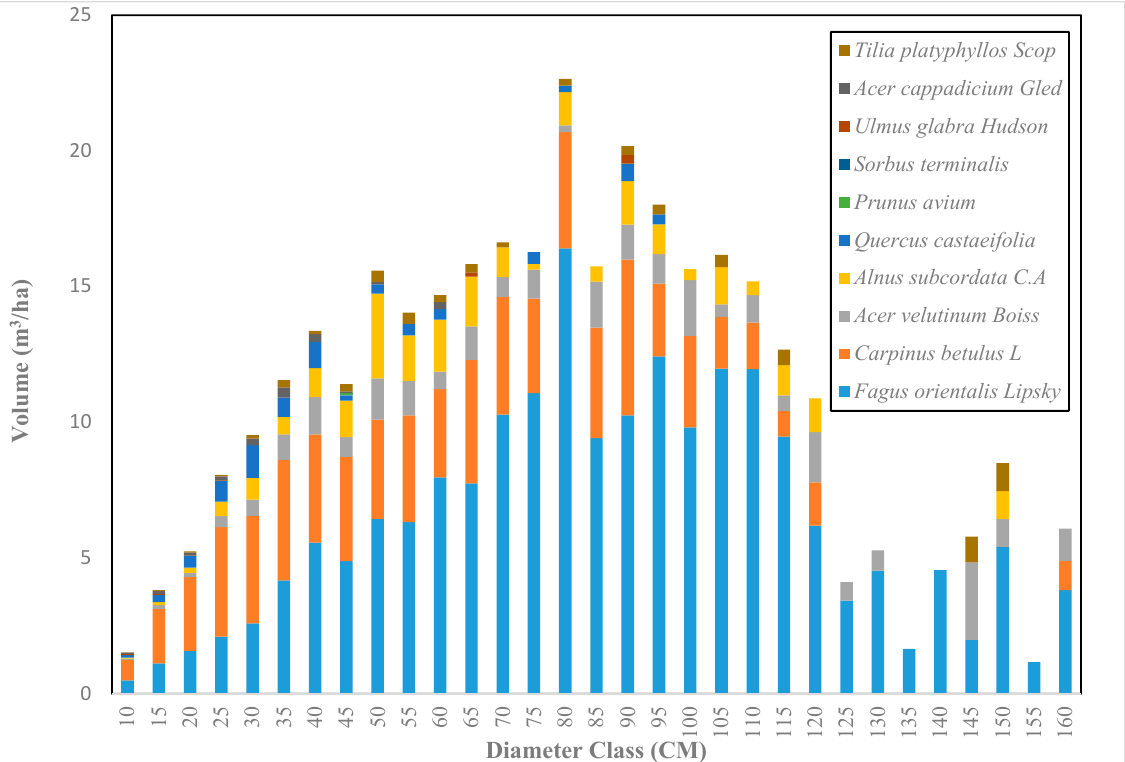
Figure 6. The volume distribution based on diameter class in the Gorazbon section in 2003.